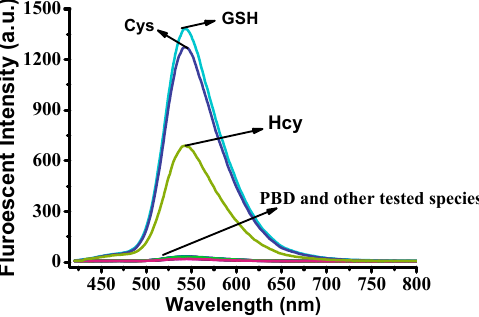
Figure 3. Fluorescence spectra of PBD (10 µM) with biothiols (100 µM) and various tested analytes (200 µM). λ ex = 405 nm.